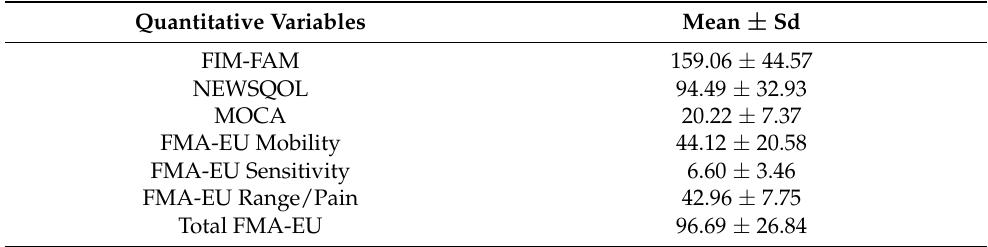
Table 1. Descriptive data of the evaluation instruments related to the clinical variables of study. Quantitative